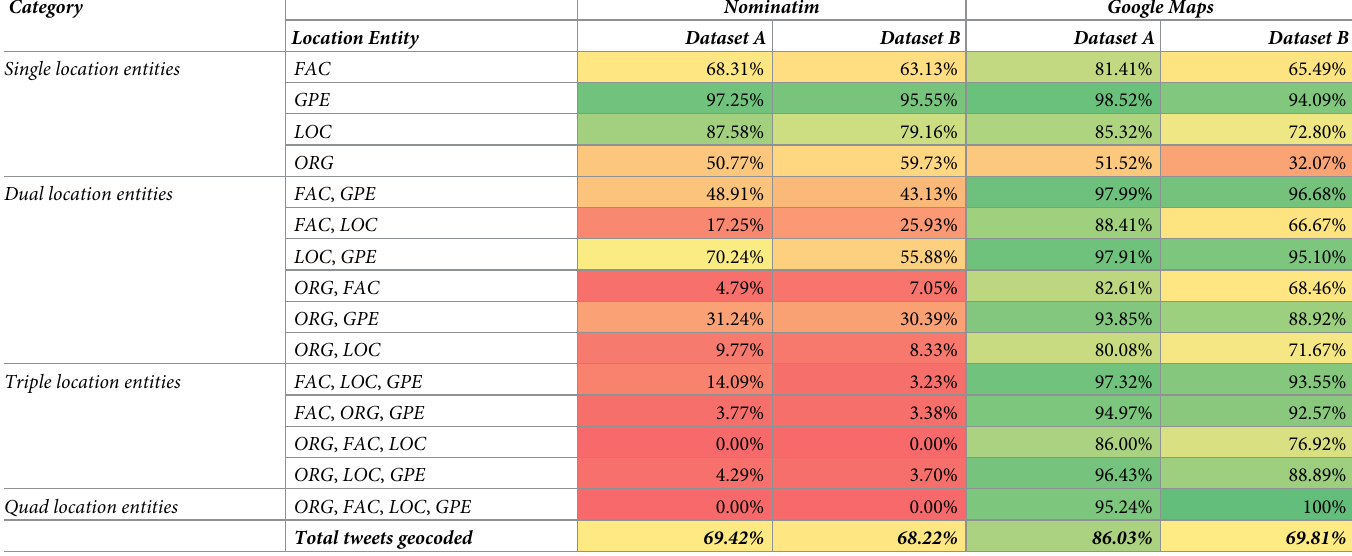
Table 5. Percentage of geocoded locations for each dataset when using either the Nominatim or Google Maps geocoder. The table is arranged by alphabetical order of the location entity and category. Category